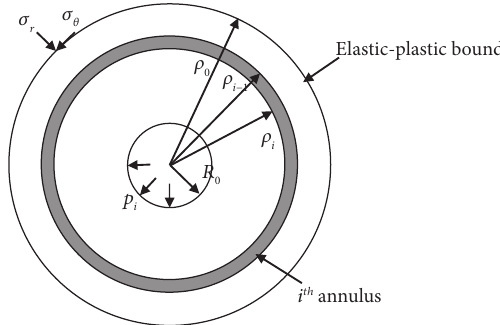
Figure 2: Normalized plastic zone analysis